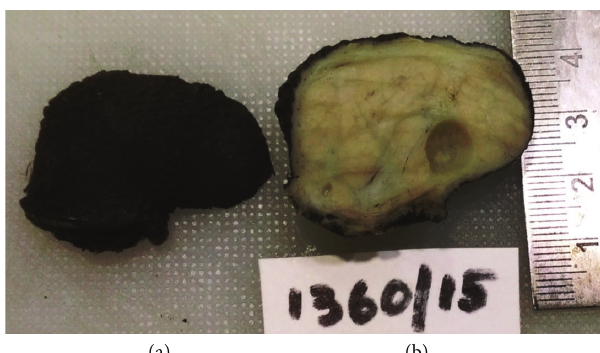
Figure 1: Gross appearance. (a) Smooth external surface of the polyp. (b) Cut surface is gray white, firm, and lobulated with cystic spaces.